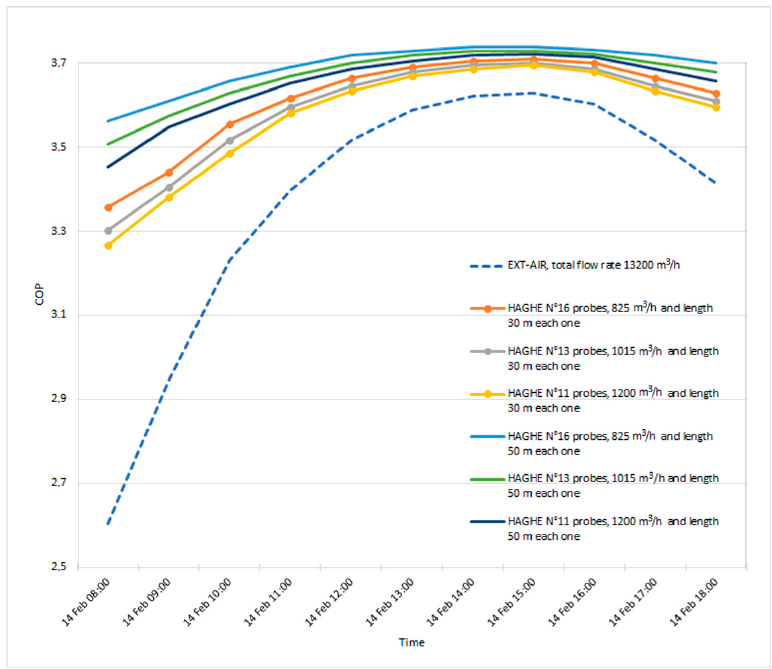
Figure 9. Comparison, in the coldest day, between COP EXT ‐ AIR and COP HAGHE by varying air flow rate and probe length: 14 February, T w = 35 °C, ground humidity = 40%, H = 3 m.